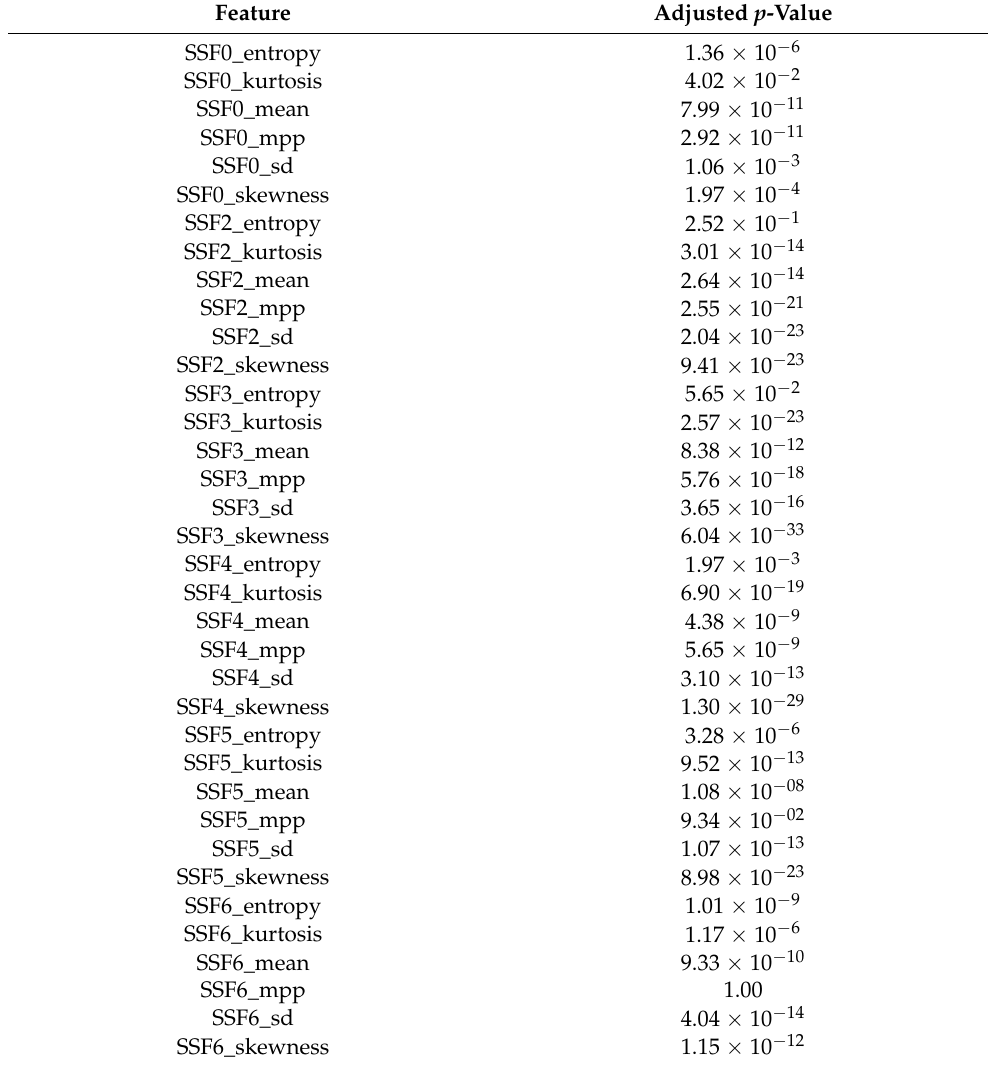
Table A1. Adjusted p -values for post hoc analysis of variance (ANOVA) among HNSCCs from three different